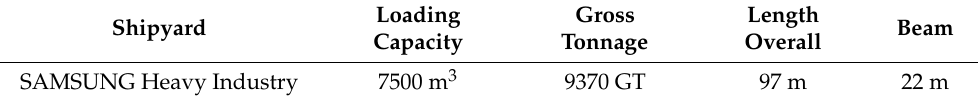
Table 2. Specifications of SM JEJU 2, an LNG bunkering combined carrier in South Korea.